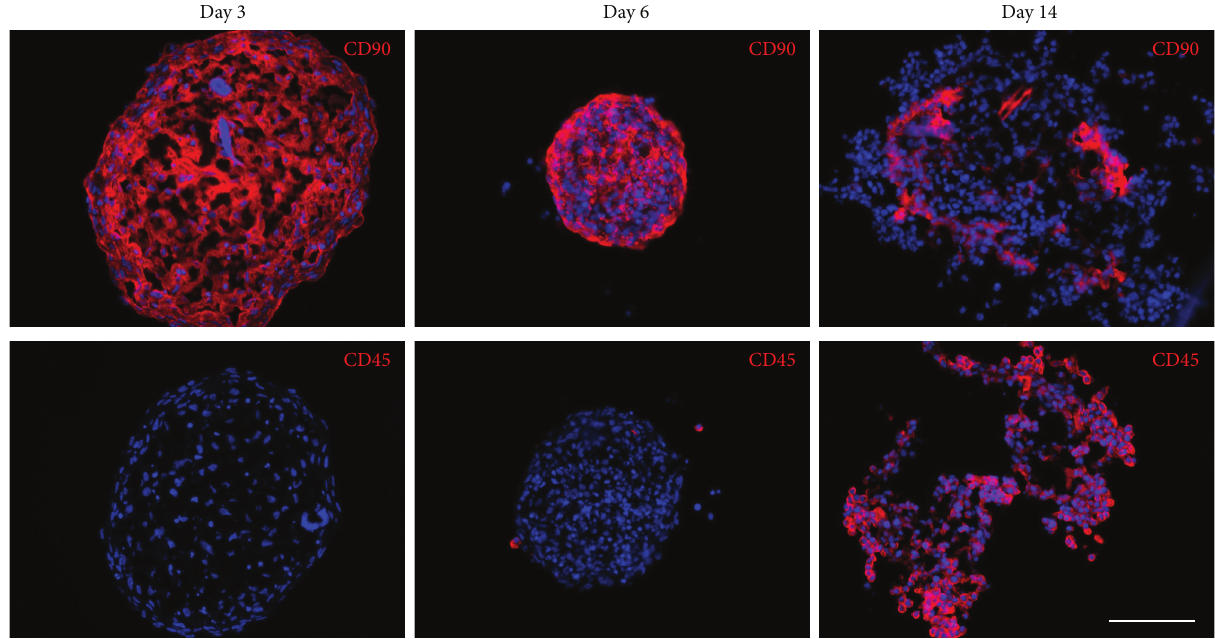
Figure 3: HSPCs, initially excluded by spheroid-forming MSCs, penetrate the spheroids after one week of coculture. Immunofluorescence staining of spheroid cryosections with antibodies against CD90 detecting MSCs and CD45 detecting hematopoietic cells revealed that on day 3 of coculture the spheroids were exclusively made up of MSCs. After 6 days of coculture, compaction of the spheroid occurred and CD90 staining was still present throughout the spheroid. Only a few CD45 + cells were attached to the spheroid surface. On day 14 of coculture, most cells were stained with the anti-CD45 antibody, while the CD90 + cells of the core seemed to be collapsed. Cell nuclei were counterstained with DAPI. Scale bar: 100 𝜇